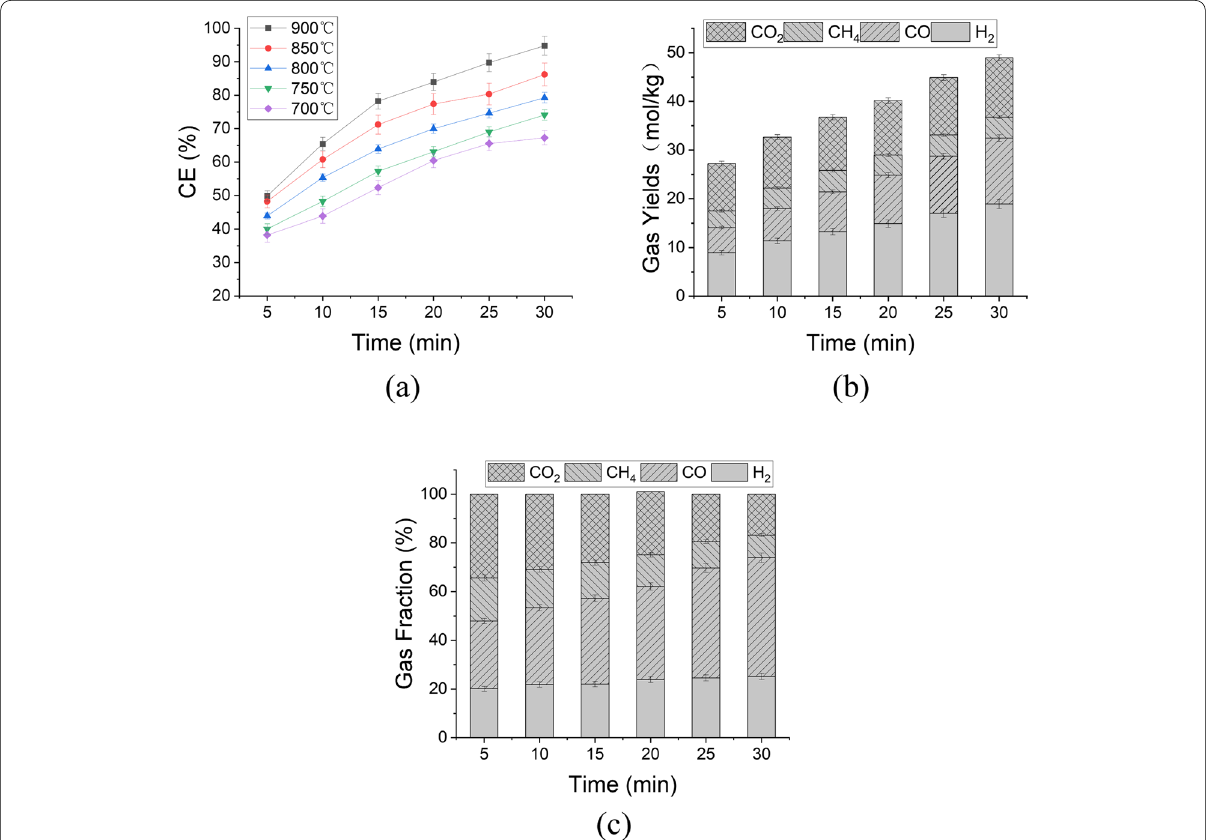
Fig. 4 Effect of reaction time on the supercritical carbon dioxide gasification of biomass (900 °C; K 2 CO 3 : Biomass gasification; c composition of the gas